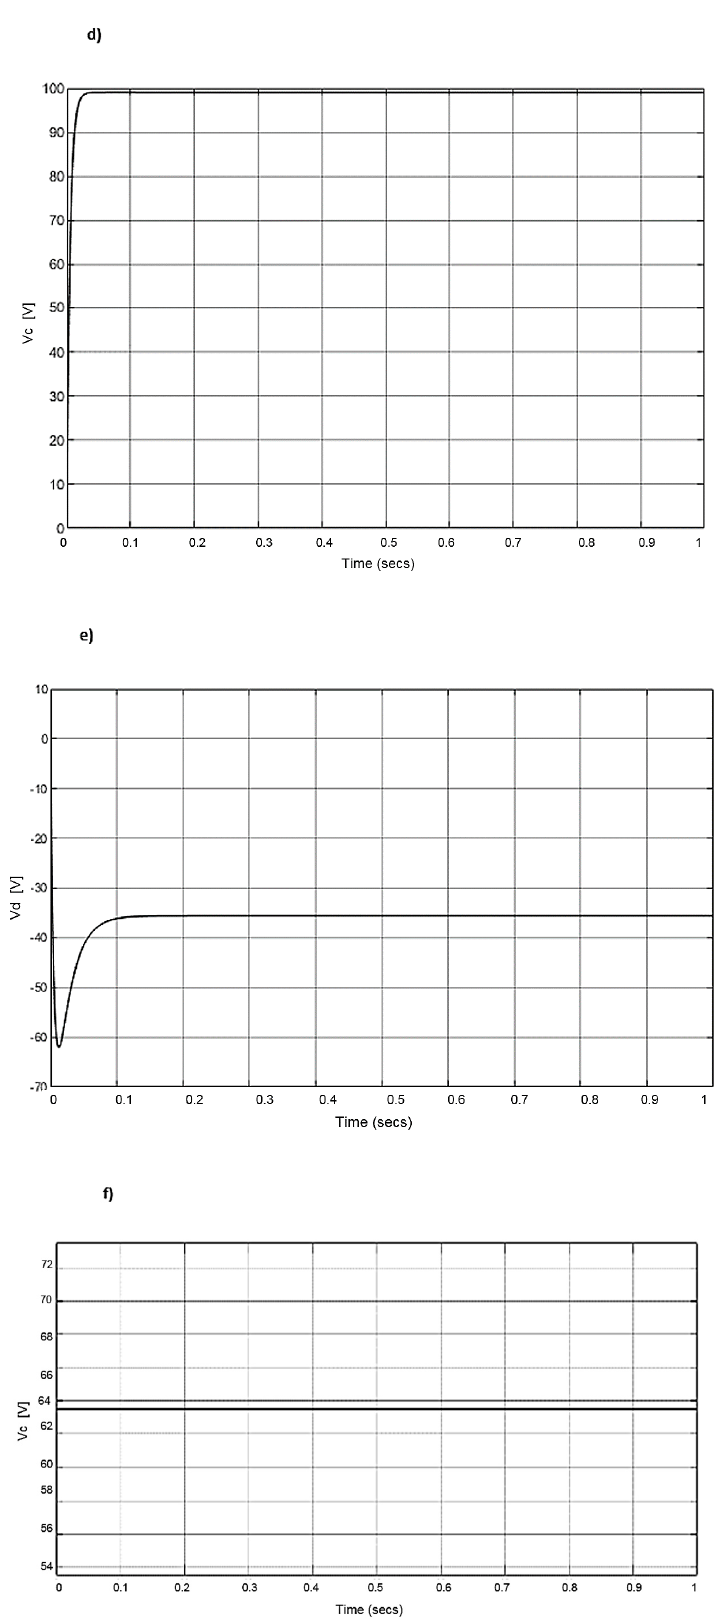
Figure A4. The courses of voltage V 0 , currents I 0 , IL , and voltages V c , and V d , versus time for the boost converter for the Li-S battery, ( a ) V 0 ; ( b ) I 0 ; ( c ) IL ; ( d ) V c ; ( e ) V d ; ( f ) V d